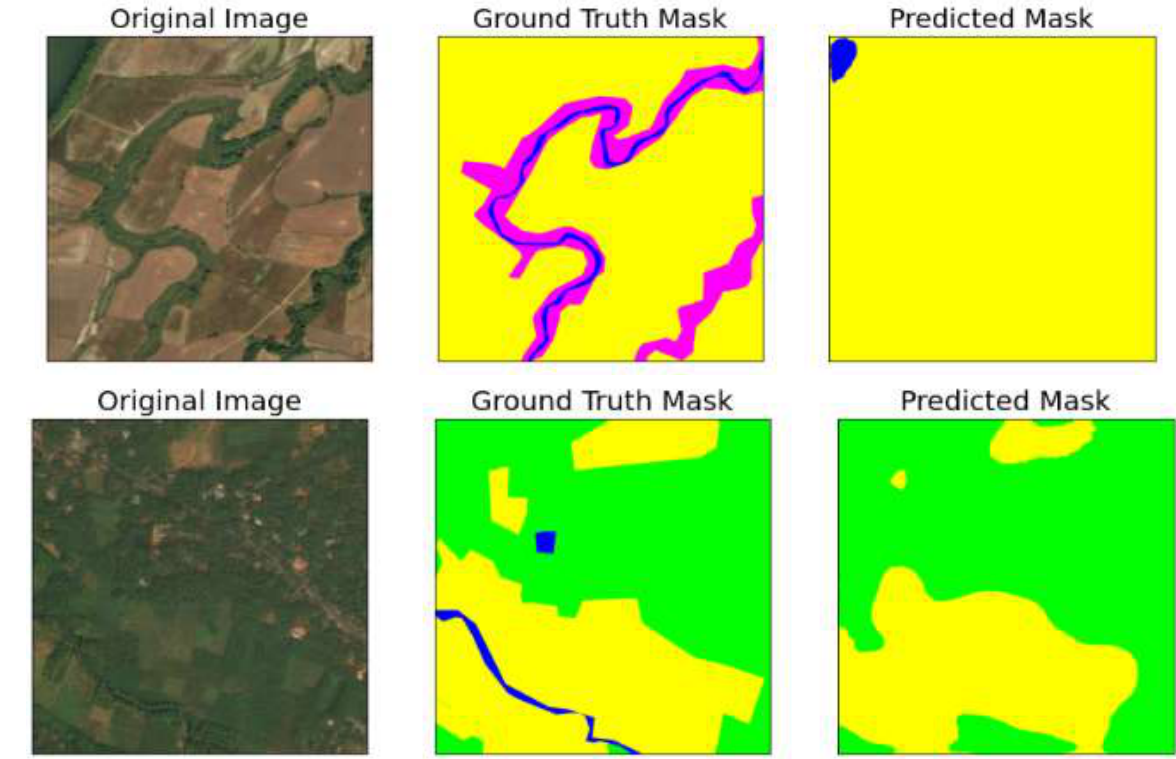
Figure 4. Examples of misclassification by the model.